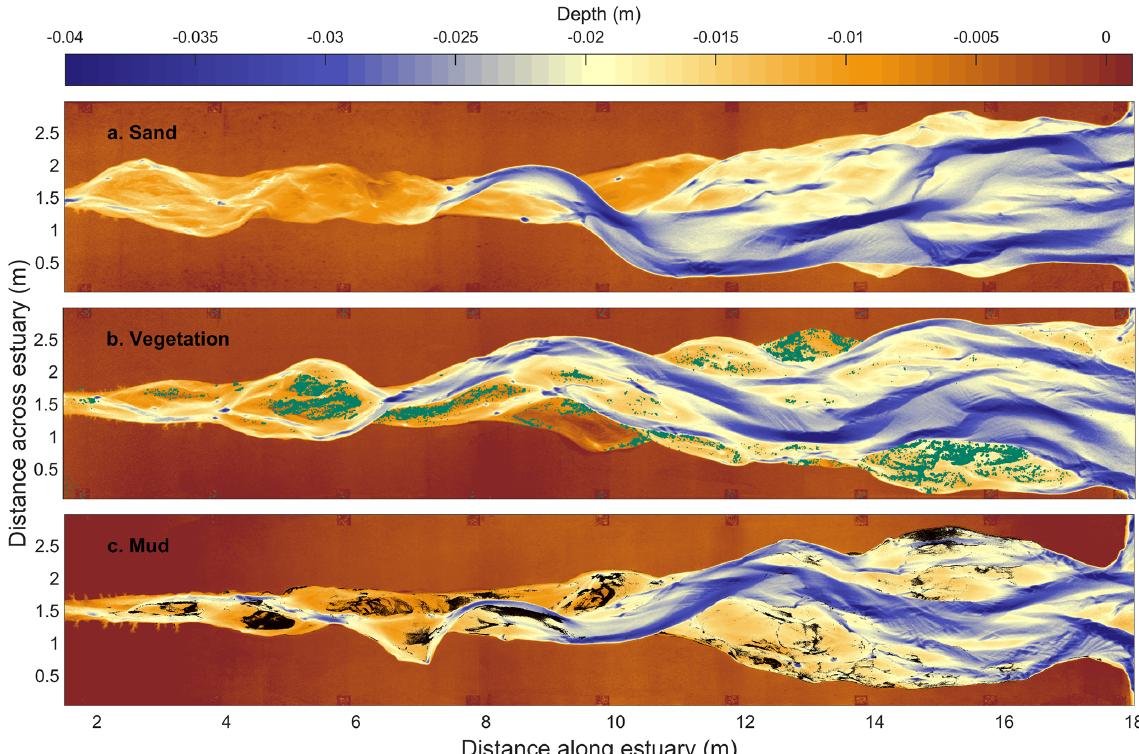
Figure 2. Bathymetry after 13000 tidal cycles (see movie in the Supplement). (a) Control experiment with only sand. (b) Estuary with two vegetation species, with cover indicated in green. For visualisation, the binary map of vegetation was dilated by a kernel of 4mm in MATLAB. (c) Estuary with mud simulant, with cover indicated in black (low mud experiment from Braat et al., 2019).